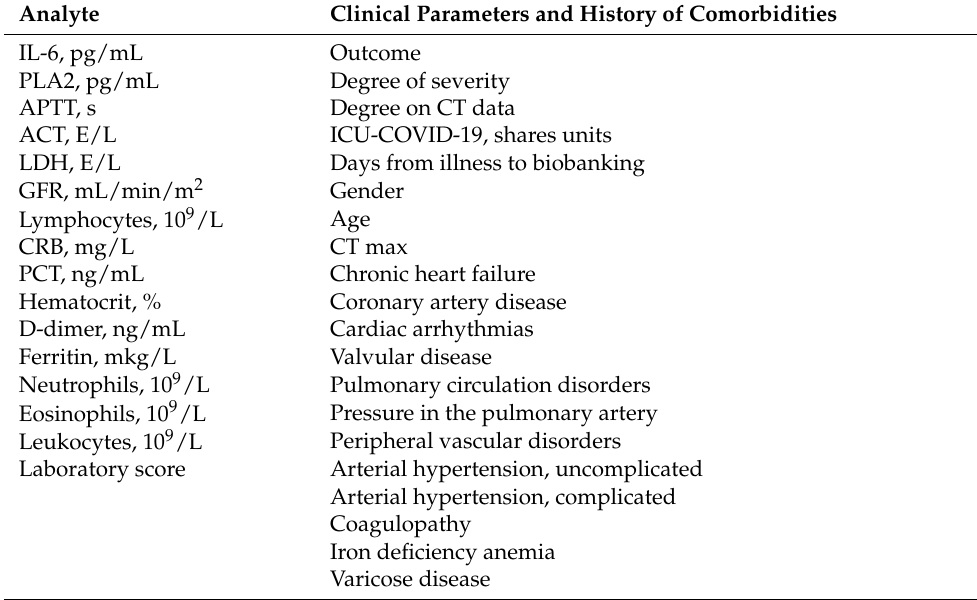
Table 8. Biochemical and clinical parameters and history of